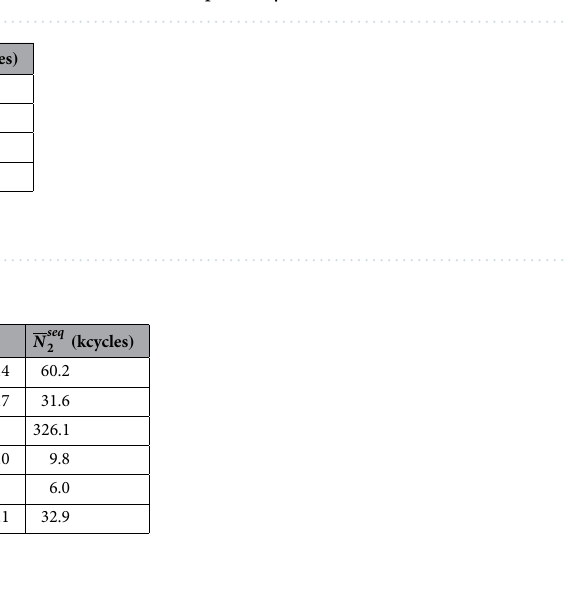
Figure 3. ( a ) Junction-to-case thermal resistance relative variation (test#4). Test conditions: T jmin = 55 °C, ∆T